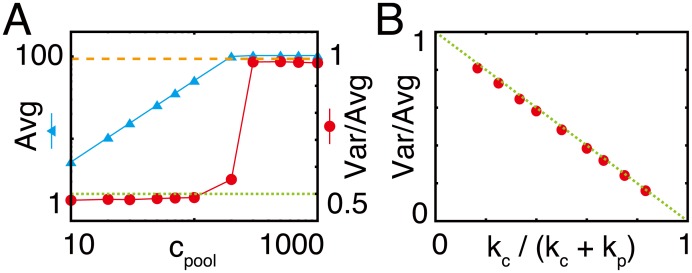
Reduced intrinsic noise in the CCC model.(A) Average and variance per average (Fano factor) of the number of m1 for different carrier concentrations. The cyan line and triangles represent the average number, and the red line and circles represent the Fano factor. The dashed orange line indicates 1 and the green dotted line indicates 0.5. kin is set to 100.0 and csum is the same as cpool. For sufficiently small values of cpool, the average number of m1 decreases linearly and the Fano factor approaches 0.5, while for the large cpool the Fano factor is approximately 1. (B) Fano factor of the number of m1 in various kc / (kc + kp). The red circles represent simulation data, and the green dotted line represents an analytical solution. kp was fixed to 1, while kc was altered to change kc / (kc + kp).